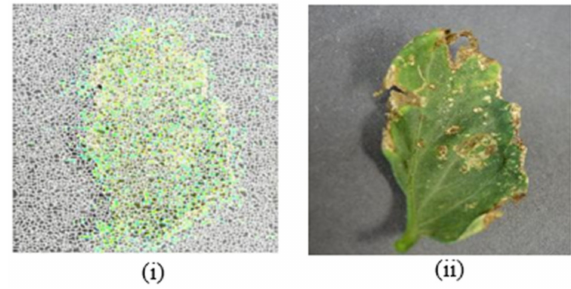
Figure 7. Effect of noise removal before ( i ) and after ( ii